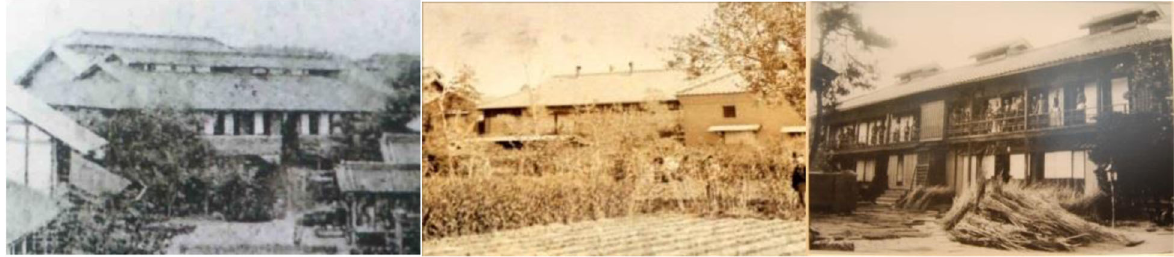
Fig. 8 Transformation of the roof ventilation system of Tajima Nobutaka residence in 1870 (left), 1897 (centre) and 1907 (right). (Source: Sakai Shimamura Committee of Photo Journal Publication,